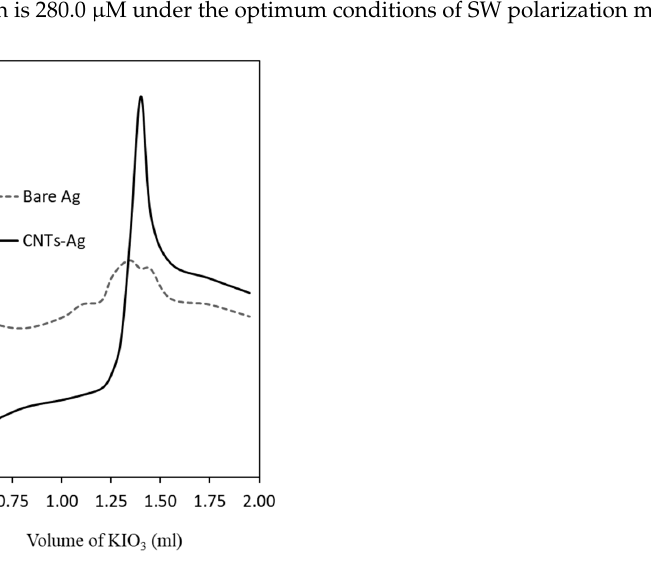
Figure 12. DEP potential peak intensity for titration of ascorbic acid with KIO3 µM under the optimum conditions of SW polarization mode, using bare Ag and CNTs-Ag electrodes. Table 1. Analytical parameters for SIA-DEP determination of ascorbic acid at CNTs-Ag electrodes with comparison against reference standard iodimetric method. The number of measurements is